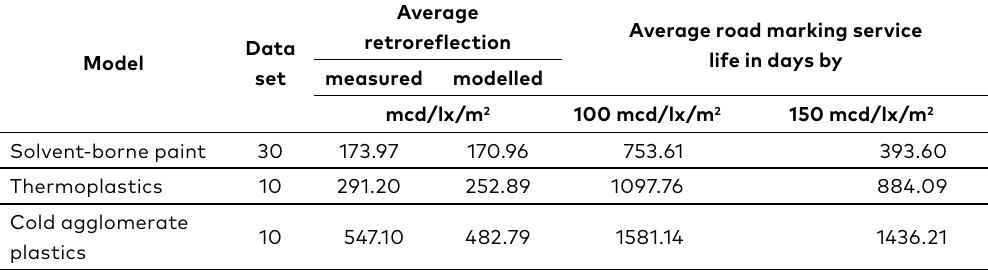
Table 3. Verification results of designed